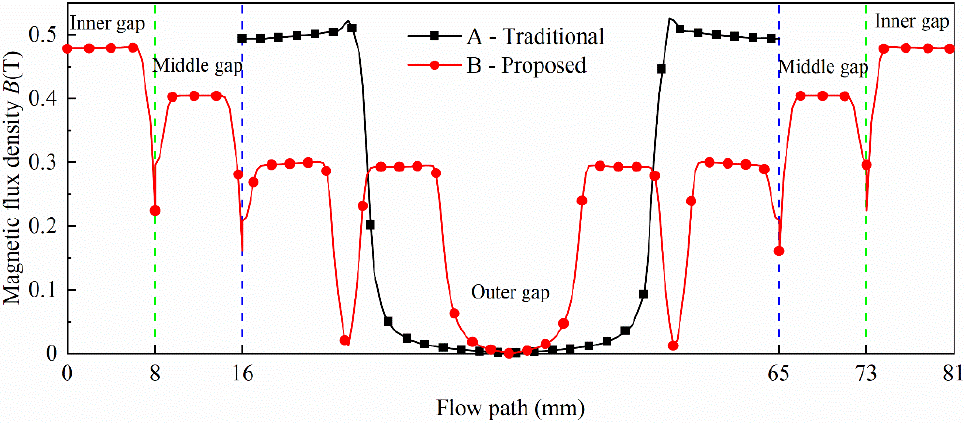
Figure 8. The comparison of the magnetic flux density between the proposed MR damper and the traditional MR damper.